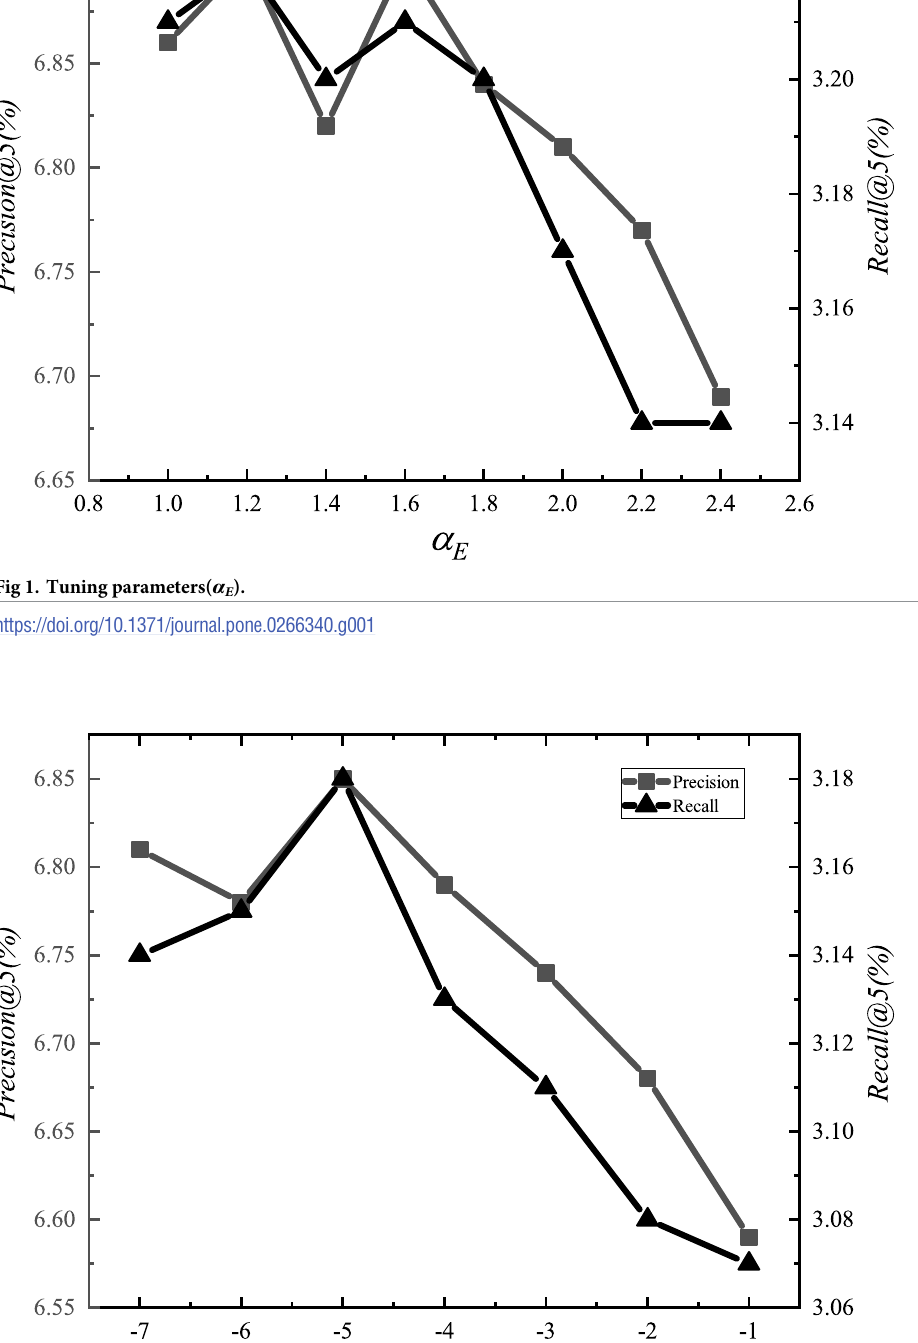
Fig 2. Tuning parameters( α G